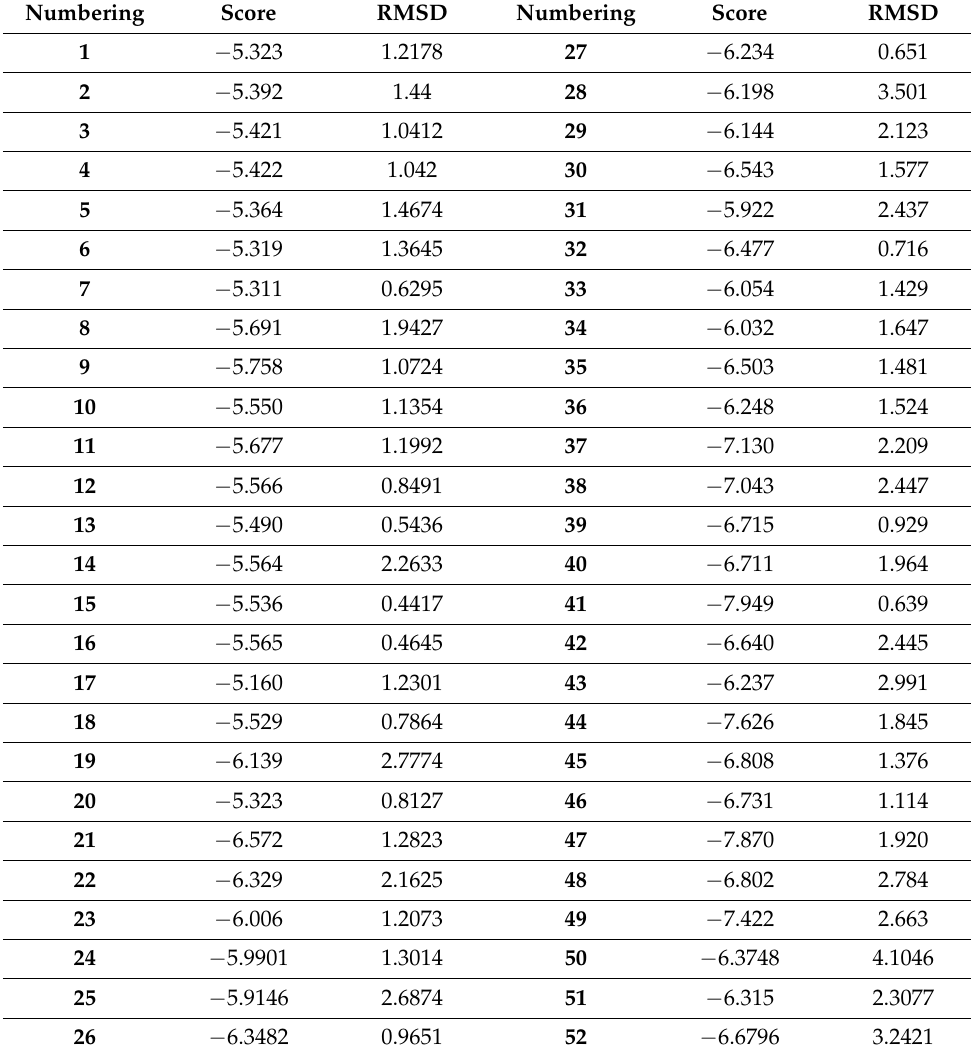
Table 4. Dock score and RMSD values were calculated for 52 compounds with COX-2